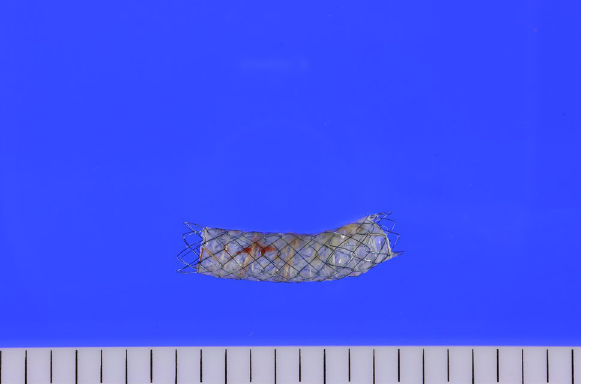
Figure 1. The removed self-expandable metal